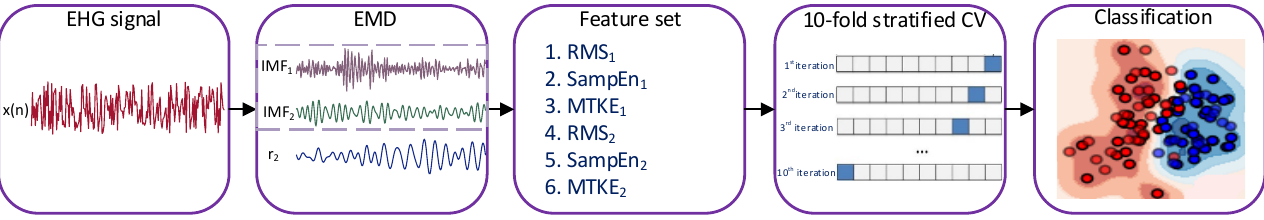
Figure 1. The block diagram for the discrimination of the